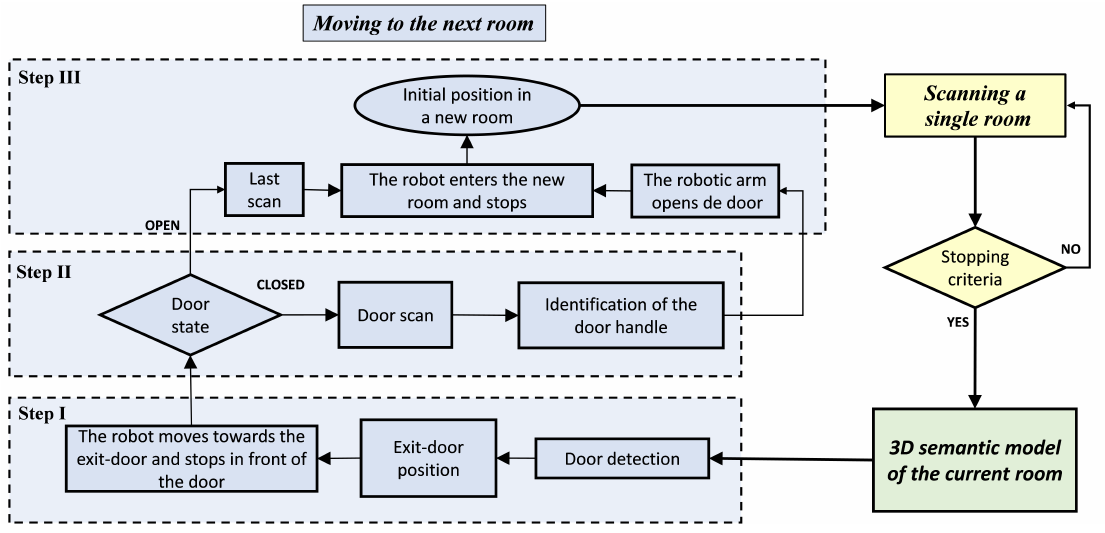
Figure 1. Main modules of the whole scanning process: data acquisition (yellow), 3D modelling (green) and moving Mobile Platform for Autonomous Digitization (MoPAD) to a contiguous room